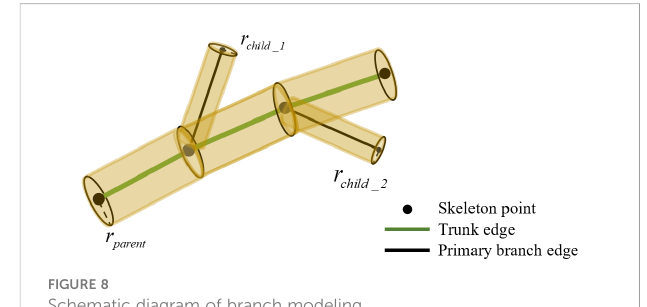
FIGURE 8 Schematic diagram of branch modeling.